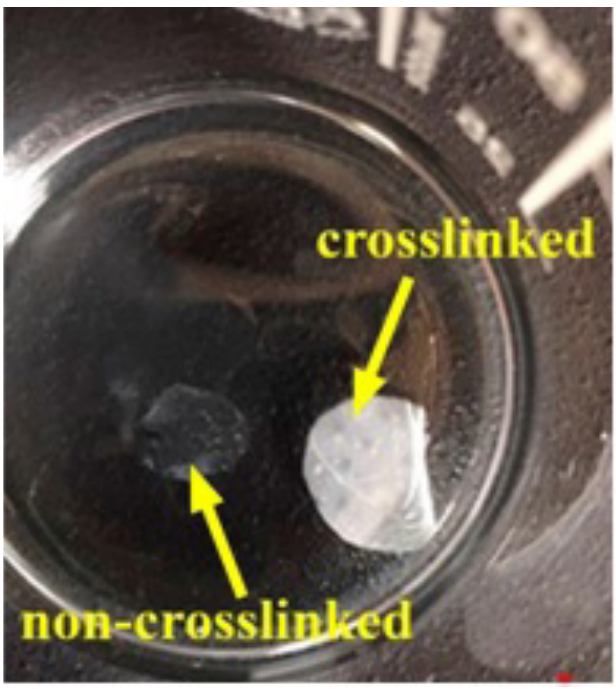
FIGURE 2 - Naftifine-loaded NFT/PVA/SA and GTA/NFT/ PVA/SA nanofiber mats after immersing in water for 24